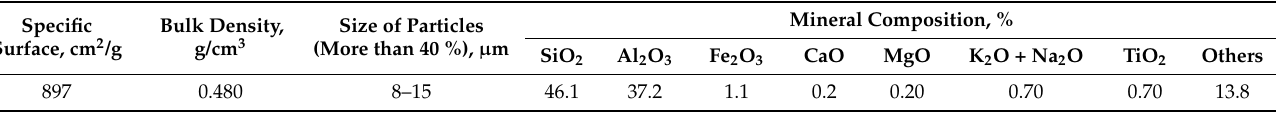
Table 3. Main characteristics of MKW.